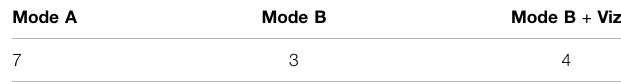
TABLE 2 | Preference scores for the three control